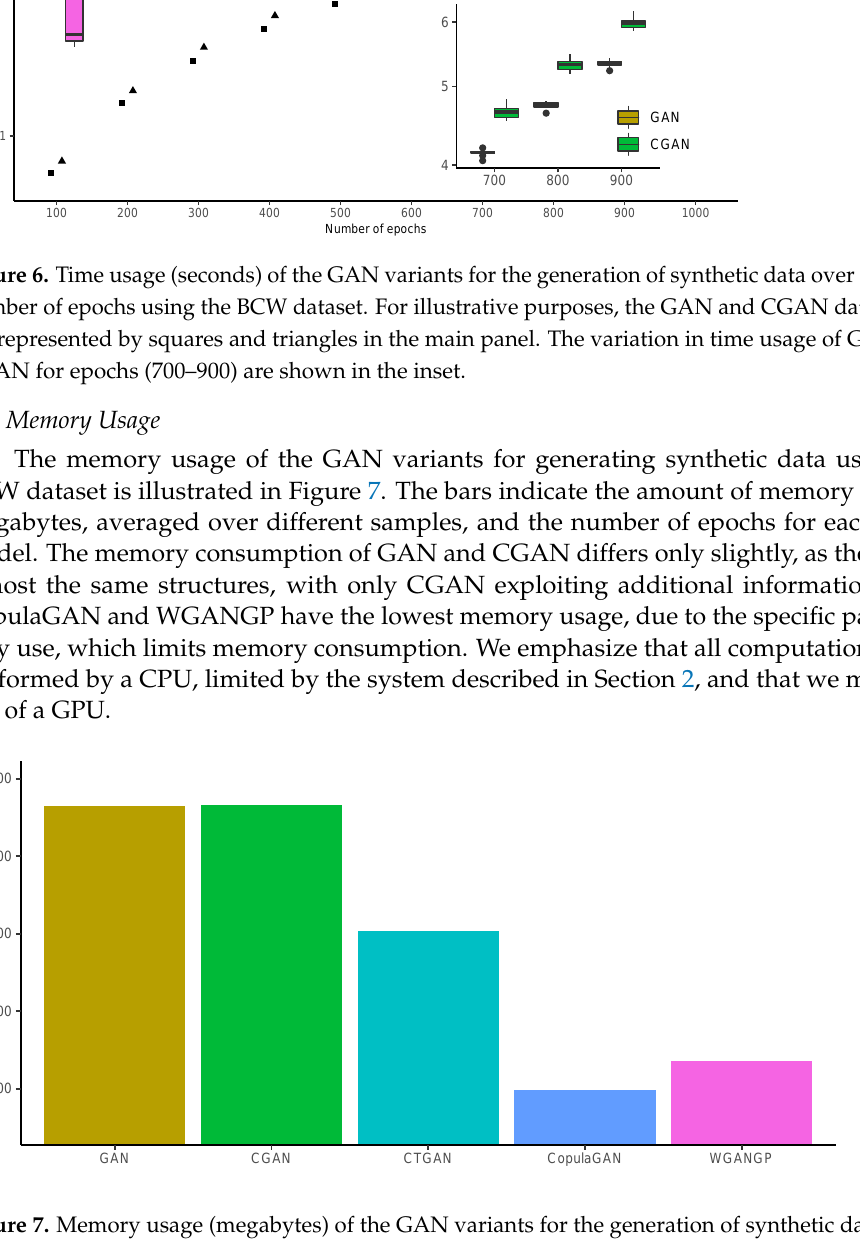
Figure 7. Memory usage (megabytes) of the GAN variants for the generation of synthetic data using the BCW